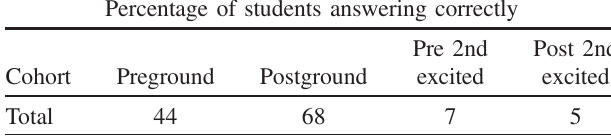
TABLE II. Average percentage of students getting each ques- tion part completely correct. Symmetry issues were not counted in the grading of the ground